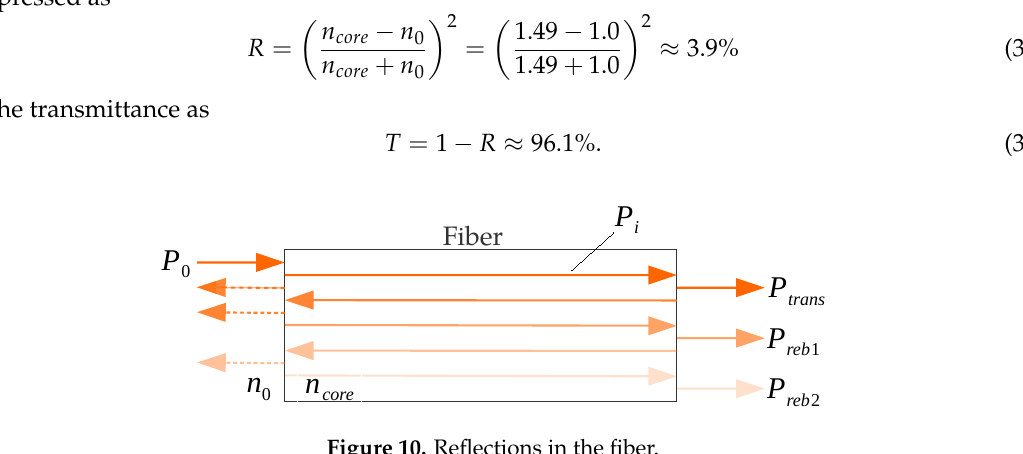
Figure 10. Reflections in the